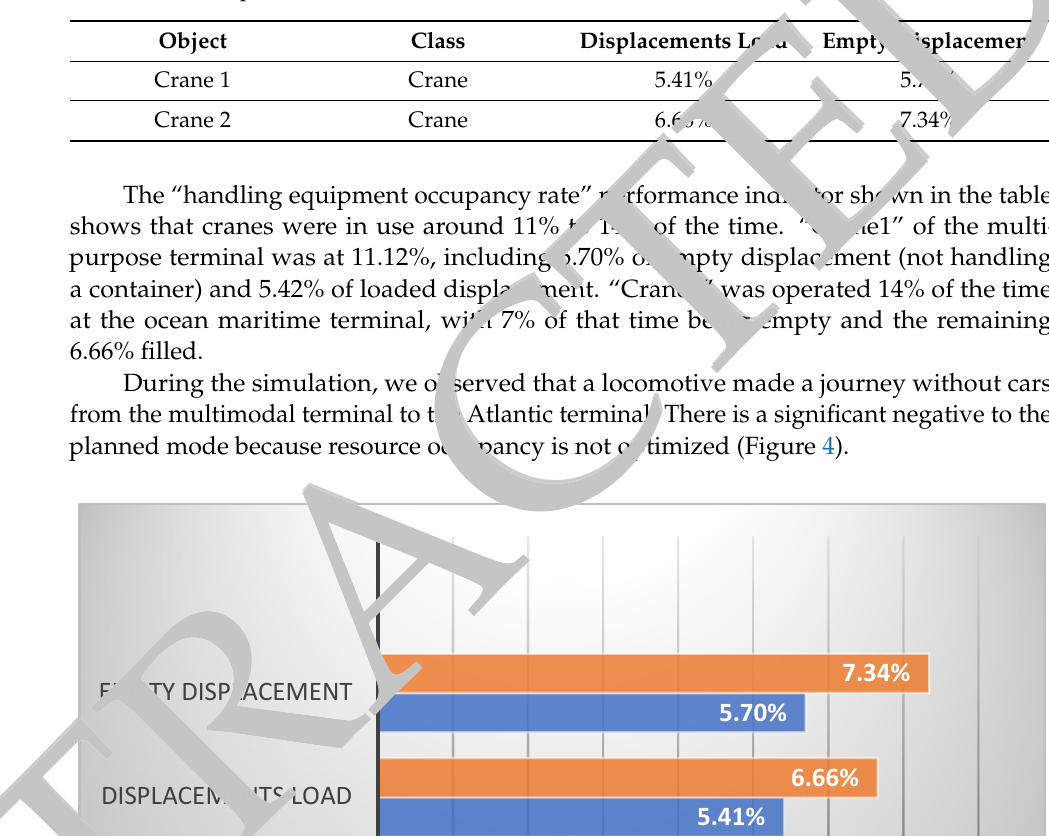
Table 2. Status report for scheduled mode.